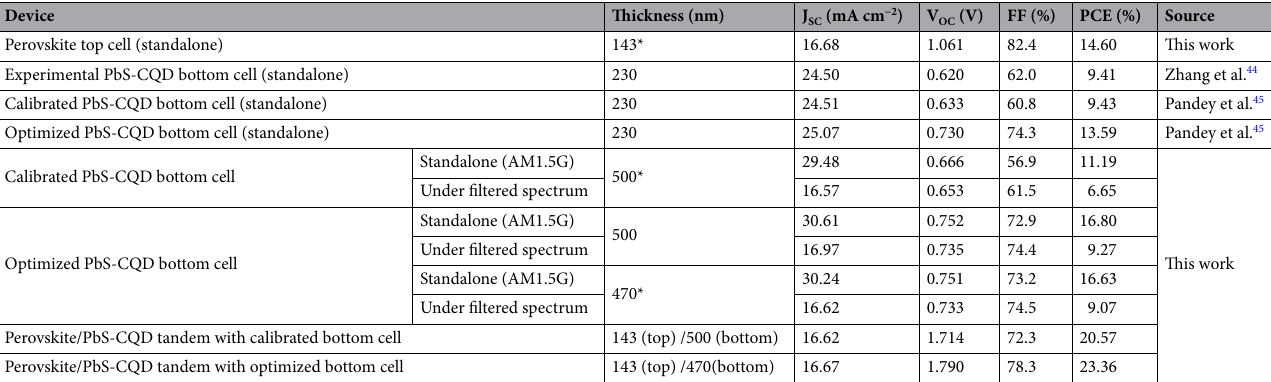
Table 3. Summary of the photovoltaic parameters of all the devices considered in this subsection. *Thickness for current